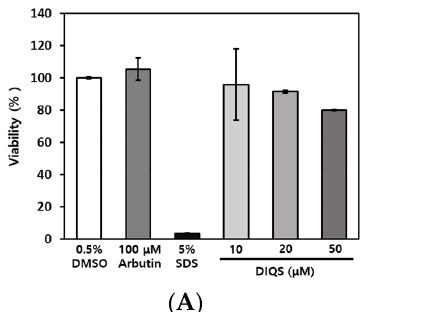
Figure 6. DIQS did not exhibit irritable effects in artificial human skin and cornea tissues. DIQS toxicity assays were performed using artificial skin and cornea models in accordance with the Organization for Economic Cooperation and Development (OECD) guidelines. ( A ) The effect of DIQS on skin irritation was tested using the Neoderm-ED reconstituted human skin model. ( B ) The effect of DIQS on acute cornea irritation was tested using the Neoderm-CD reconstituted human cornea model.